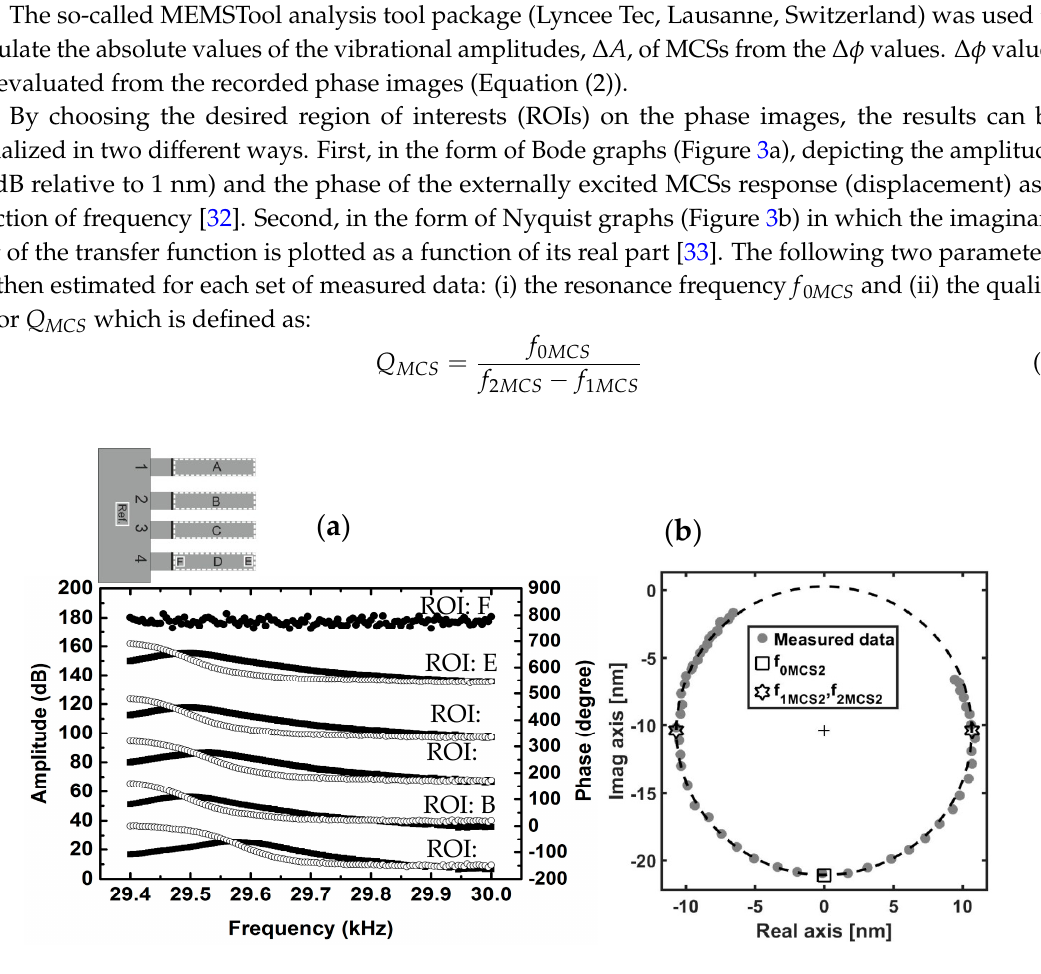
Figure 3. ( a ) Bode graph for six different ROIs on the MCSs at T = 298 K. At the resonance frequency of f 0 MCSs , the cantilever response is in phase quadrature (i.e., θ = − π /2) with the excitation signal. On the vertical axes on left- and right-hand sides, the amplitude and phase values for A, B, C, D, and E ROIs are shifted by the values of 30 dB and 160 degrees with respect to each other, respectively. For ROI F, the amplitude values are shifted by the value of 60 dB. The region shown as Ref. is the reference area; ( b ) The real-imaginary Nyquist plane of the experimental data for MCS2 from the ROI B (gray dots) with the circle fit (dashed black line). The evaluated resonance frequency f 0 MCS 2 at θ = − π /2 (square) was determined with 0.1 Hz precision as f 0 MCS 2 = 29.4946 kHz. The quality factor is also calculated by evaluating the bandwidth, Δ f MCS 2 = f 2 MCS 2 − f 1 MCS 2 (hexagrams). In this case, the quality factor is (cid:1843) (cid:3014)(cid:3004)(cid:3020)(cid:2870) =